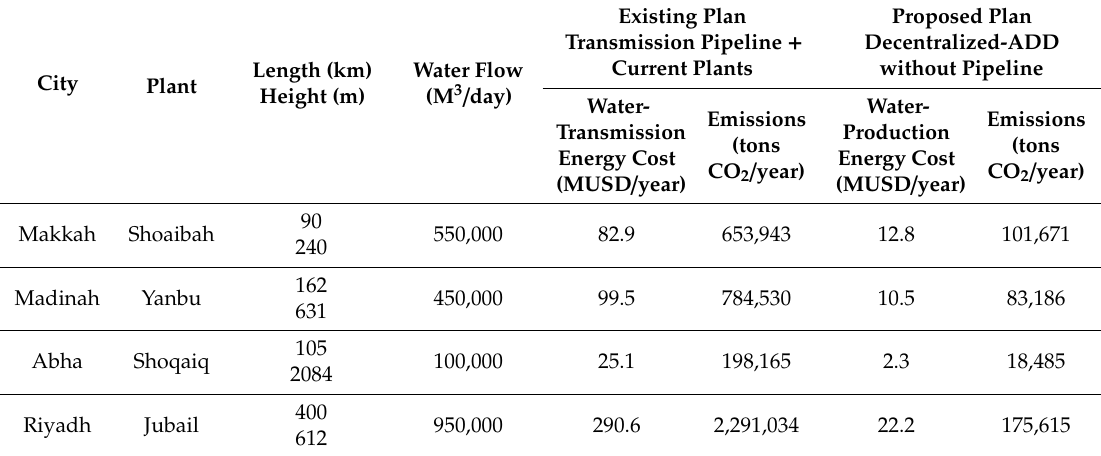
Table 7. Potential impact of using ADD and decentralization on energy consumption and CO 2 emissions on existing systems in SA by the Saline Water Conversion Corporation